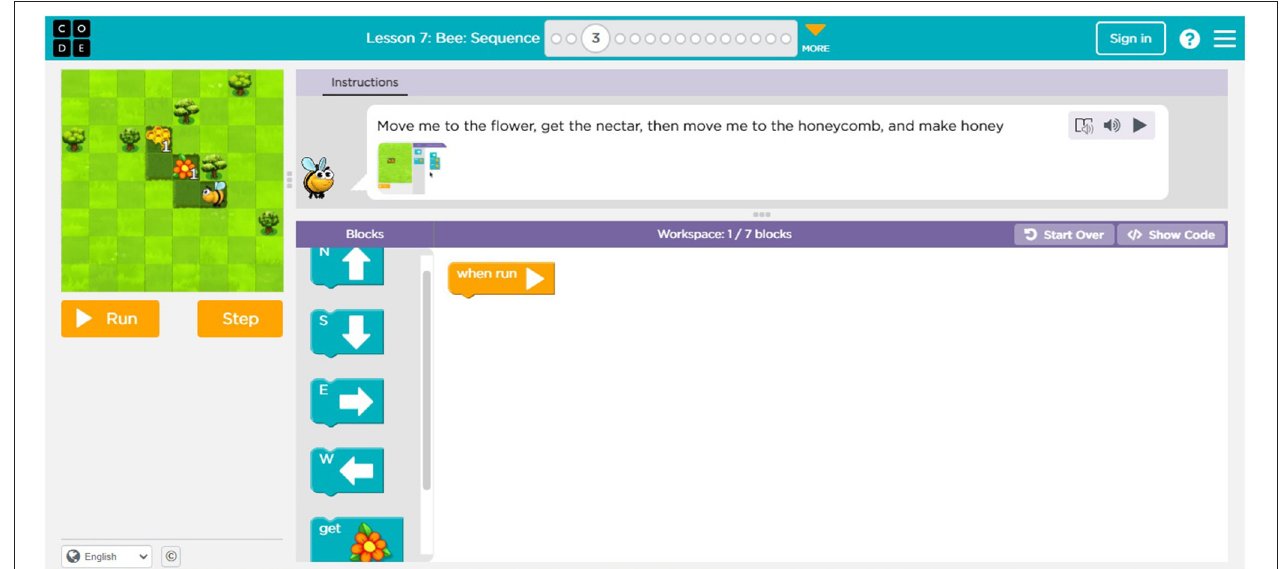
FIGURE 1 | Lesson 7, course 1 (https://studio.code.org/s/course1/lessons/7/levels/3?lang=en-US) .